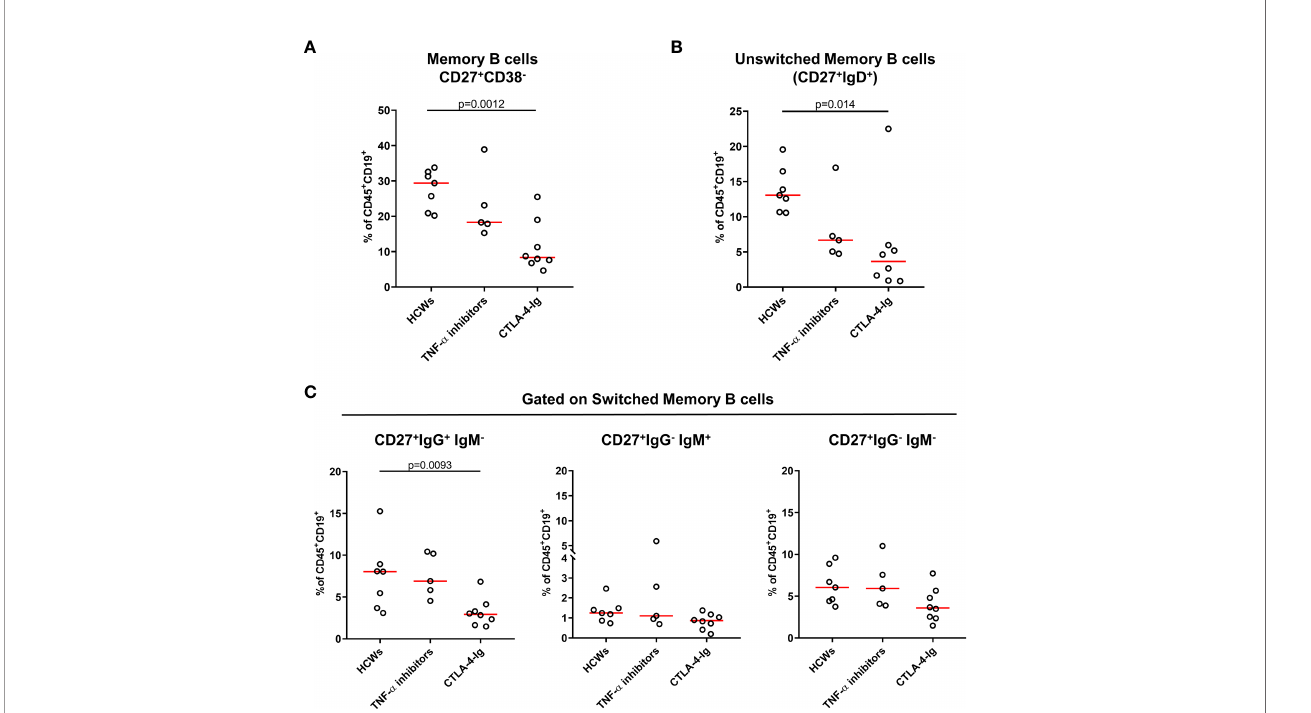
FIGURE 5 | Evaluation of memory B-cell phenotype of RA patients by fl ow cytometry. Frequency of memory B cells of HCWs (n = 7) and RA patients (n = 13) was evaluated by fl ow cytometry. Within RA patients, 5 subjects were treated with TNF- a inhibitors and 8 with CTLA-4-Ig. Frequency of (A) memory B cells (CD27 + CD38 - ), subdivided also as (B) unswitched memory B cells (CD27 + IgD + ) and (C) switched memory B cells, is shown. Within the switched memory B cells, CD27 + IgG + IgM - , CD27 + IgG - IgM + , and CD27 + IgG - IgM - cells were included. Values are reported as percentage of total CD19 + CD45 + B cells. Each dot represents an individual, and the red horizontal line represents medians. Mann – Whitney U-test with Bonferroni correction (p ≤ 0.025) was used for the statistical analysis. RA, rheumatoid arthritis; HCWs, health care workers.